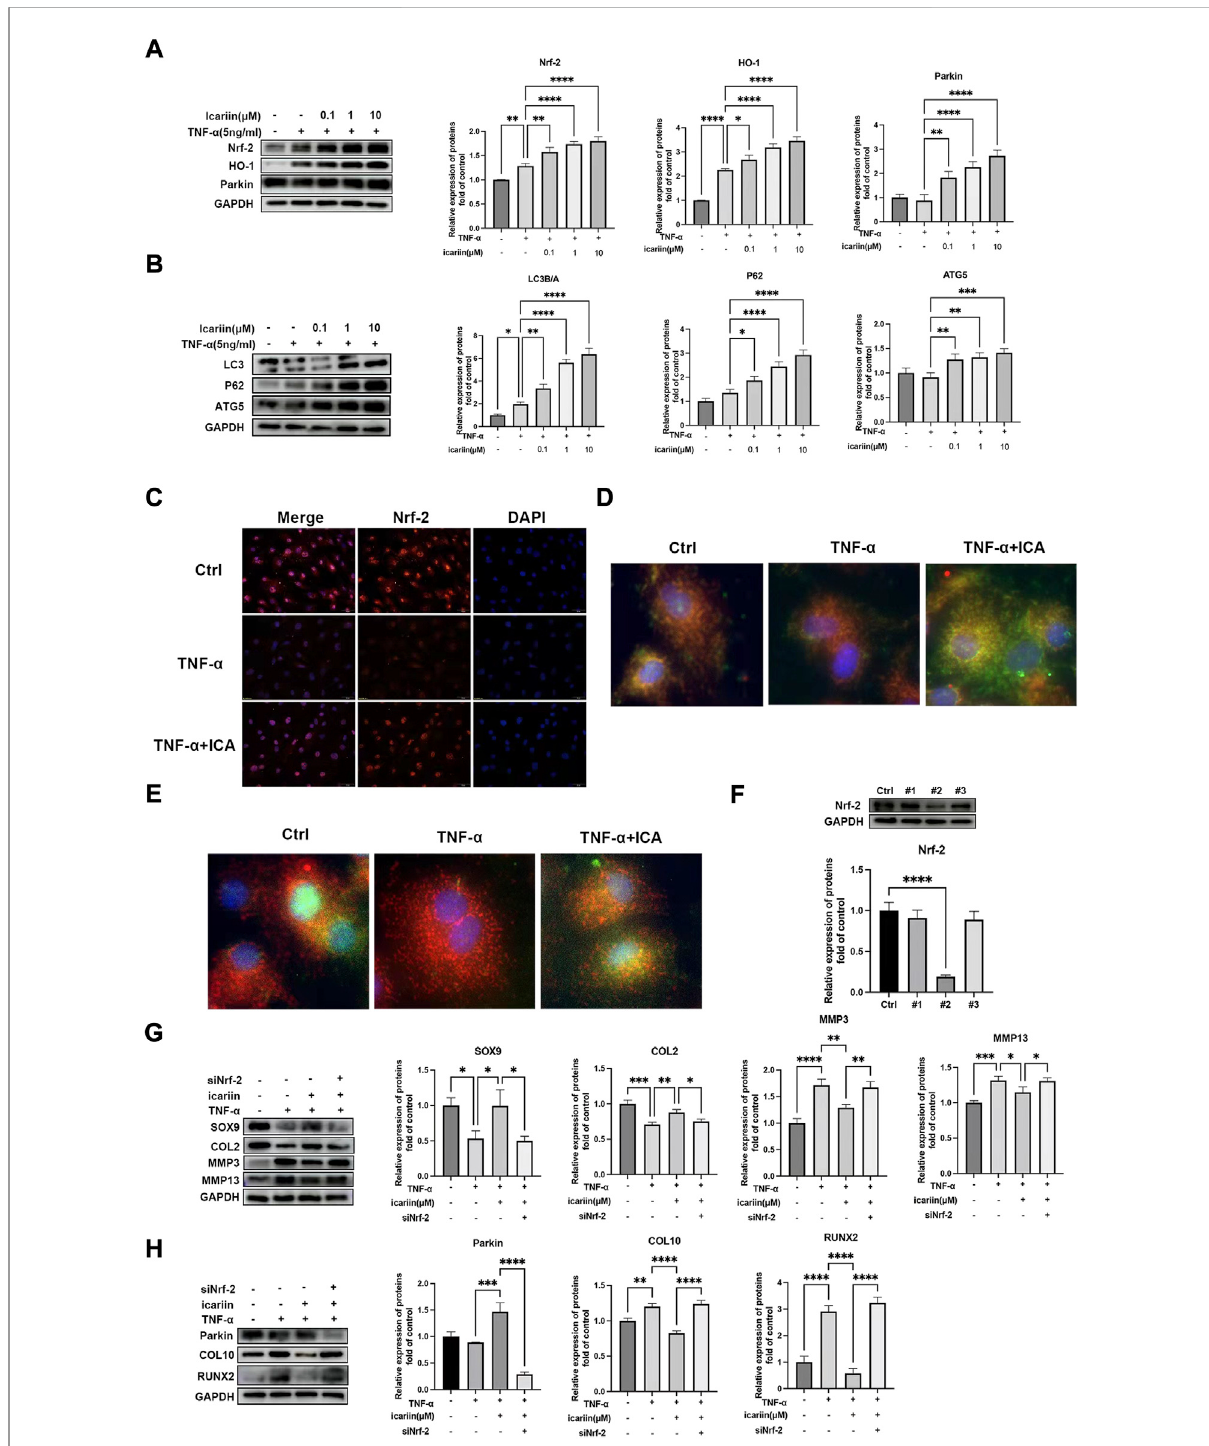
FIGURE 5 ICA protected against TNF- α induced endplate chondrocytes ECM degradation and apoptosis via activating the Nrf-2/HO-1 pathway. (A – B) Chondrocytes weretreated with TNF- α (5 ng/ml) andICA (0.1,1,and 10 μ M)for 24 h,and Western blotwasconductedto examine theproteinlevels of Nrf-2, HO-1, Parkin, LC3A/B, P62, and ATG5. The band densities of Nrf-2, HO-1, Parkin, the ratio of LC3B/A, P62, and ATG5 were quanti fi ed and normalized to control. (C) Chondrocytes were treated with TNF- α (5 ng/ml) with or without ICA (10 μ M) for 24 h and immuno fl uorescence staining of Nrf-2 was conducted. Scale bar = 20 µm. (D) Chondrocytes were treated with TNF- α (5 ng/ml) with or without ICA (10 μ M) for 24 h and immuno fl uorescencestainingwasconductedtoexaminetheexpressionandlocalizationofParkin(green)andmitochondria(red). (E)